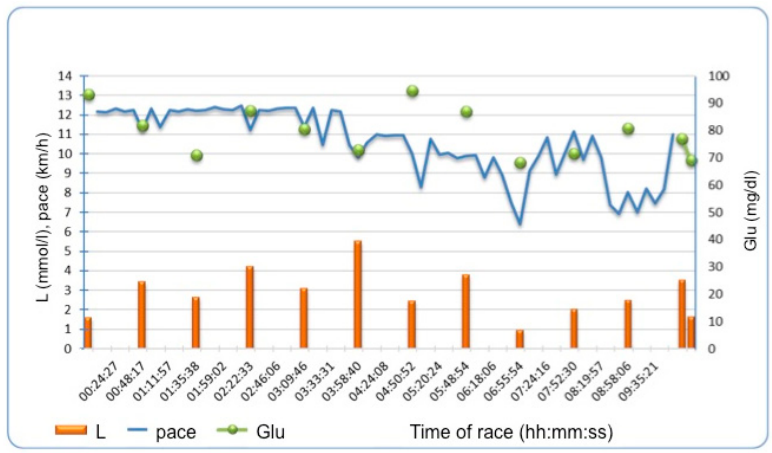
Figure 2. Example of lactate and glucose fluctuations during the race and running pace in one of the runners. L—lactate, Glu- glucose.